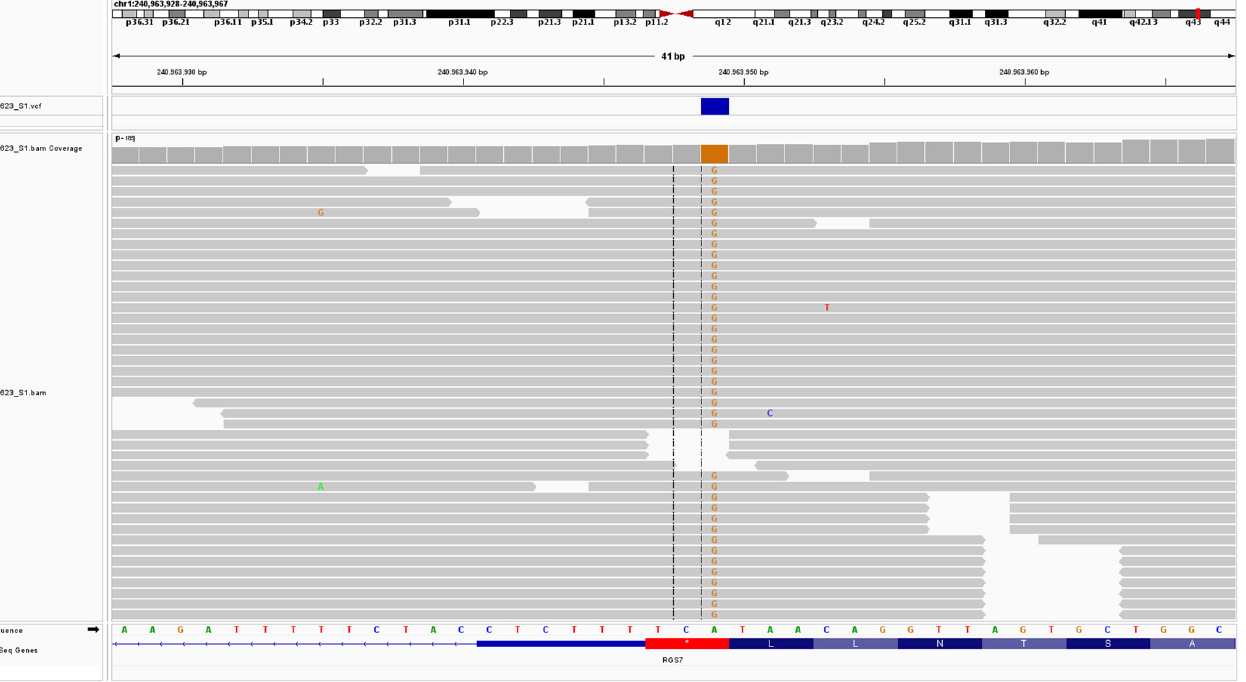
Figure 4. Integrative Genomics Viewer (IGV) [40] snapshot of the alignments showing the homozy-